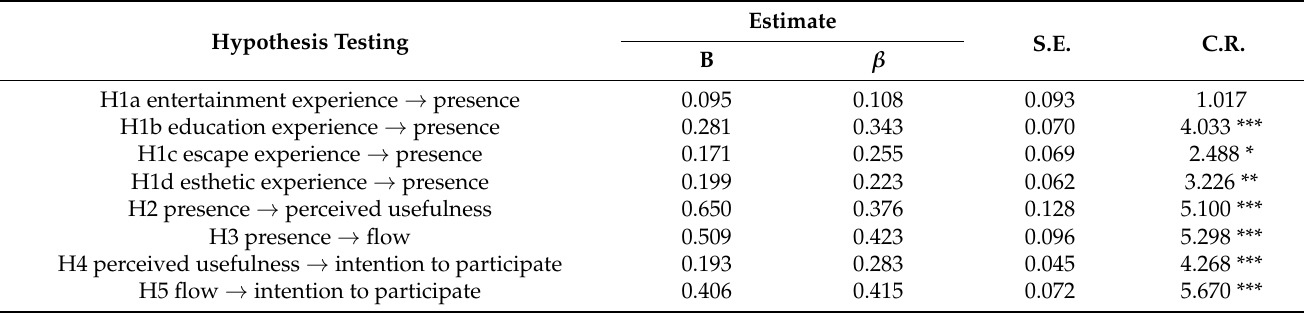
Table 6. Structural model analysis